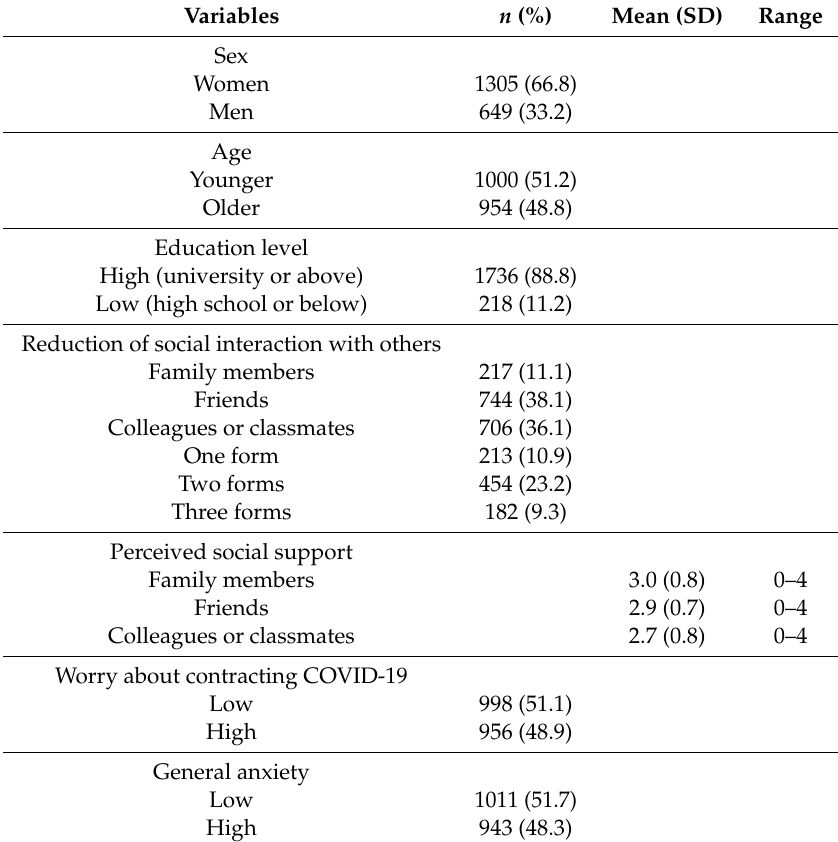
Table 1. Demographic Characteristics, Reduction of Social Interaction, and Perceived Social Support, Worry About Contracting COVID-19, and General Anxiety During the COVID-19 Pandemic (N = 1954).